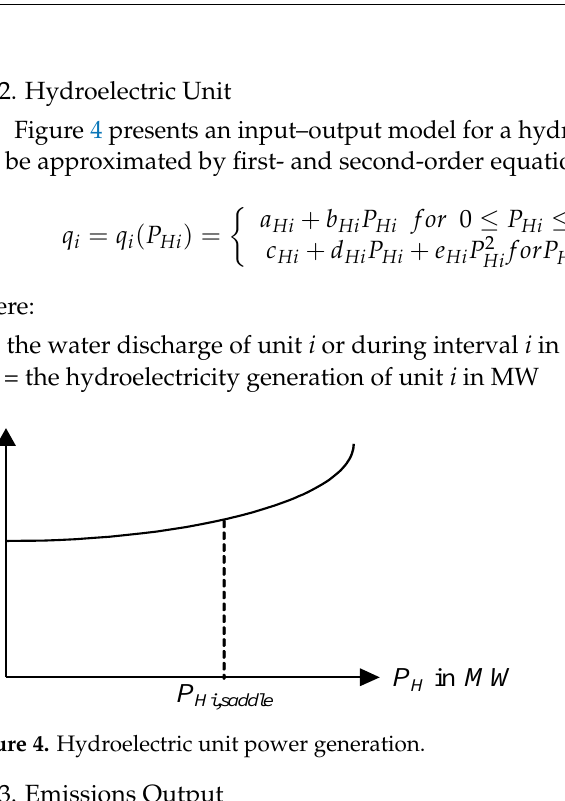
Figure 3. Typical fuel–cost curve for steam generation [13].